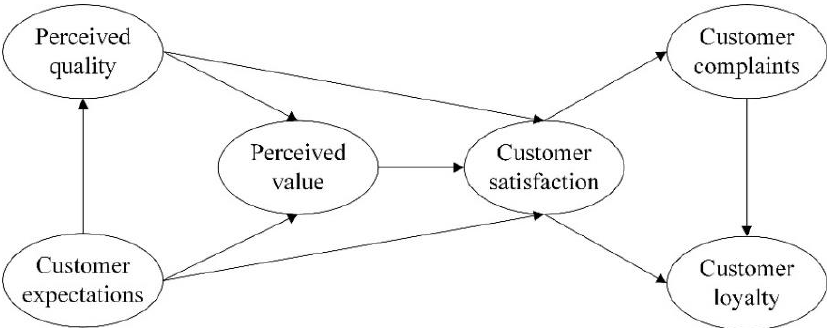
Figure 1. Structure of the ACSI model.